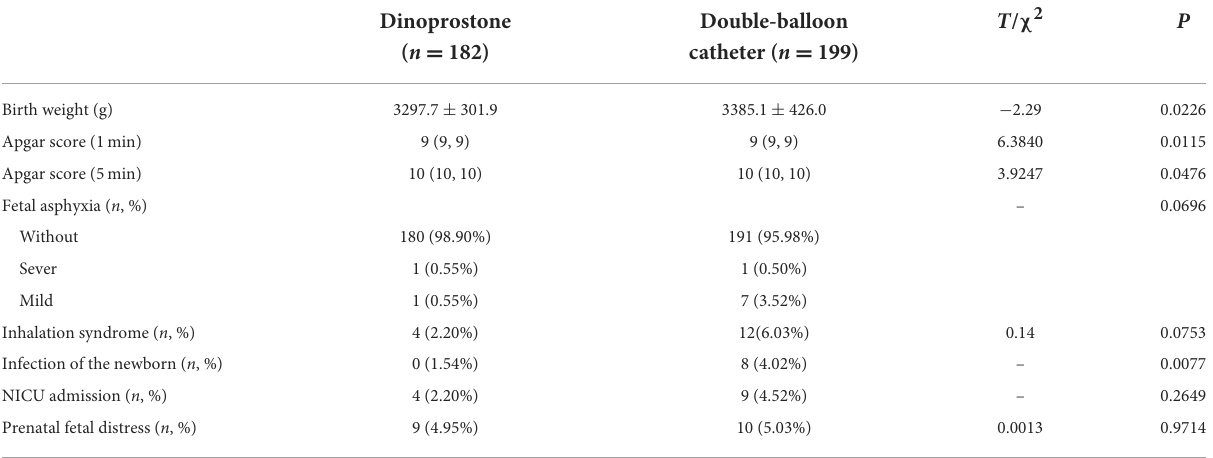
TABLE 5 The comparison of neonatal outcomes in two